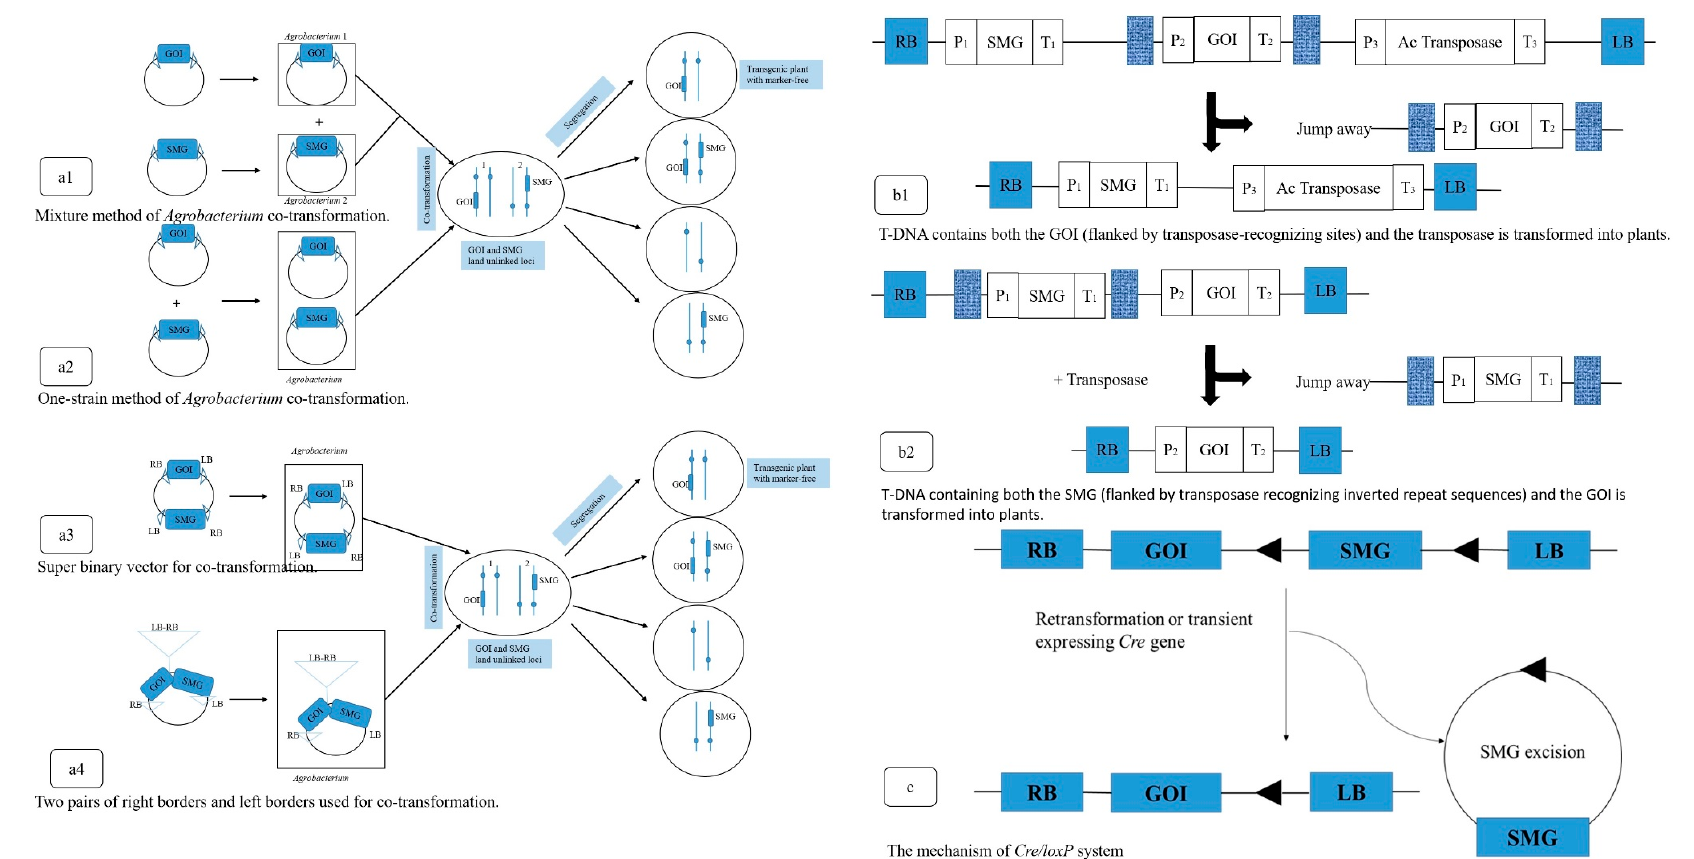
Figure 1. Mechanism of the three approaches for the removal of selectable marker genes from transgenic plants [10]. ( a ) The mechanism of co-transformation to removal of selectable marker genes from transgenic plants. a1, Mixture method of Agrobacterium co-transformation. a2, One-strain method of Agrobacterium co-transformation. a3, Super binary vector for co-transformation. a4, Two pairs of right borders and left borders used for co-transformation; ( b ) The mechanism of transposon-mediated transgene reintegration to removal of selectable marker genes from transgenic plants. b1, T-DNA contains both the GOI (flanked by transposase-recognizing sites) and the transposase is transformed into plants. b2, T-DNA containing both the SMG (flanked by transposase recognizing inverted repeat sequences) and the GOI is transformed into plants; ( c ) The mechanism of site-specific recombination (SSR) to removal of selectable marker genes from transgenic plants.